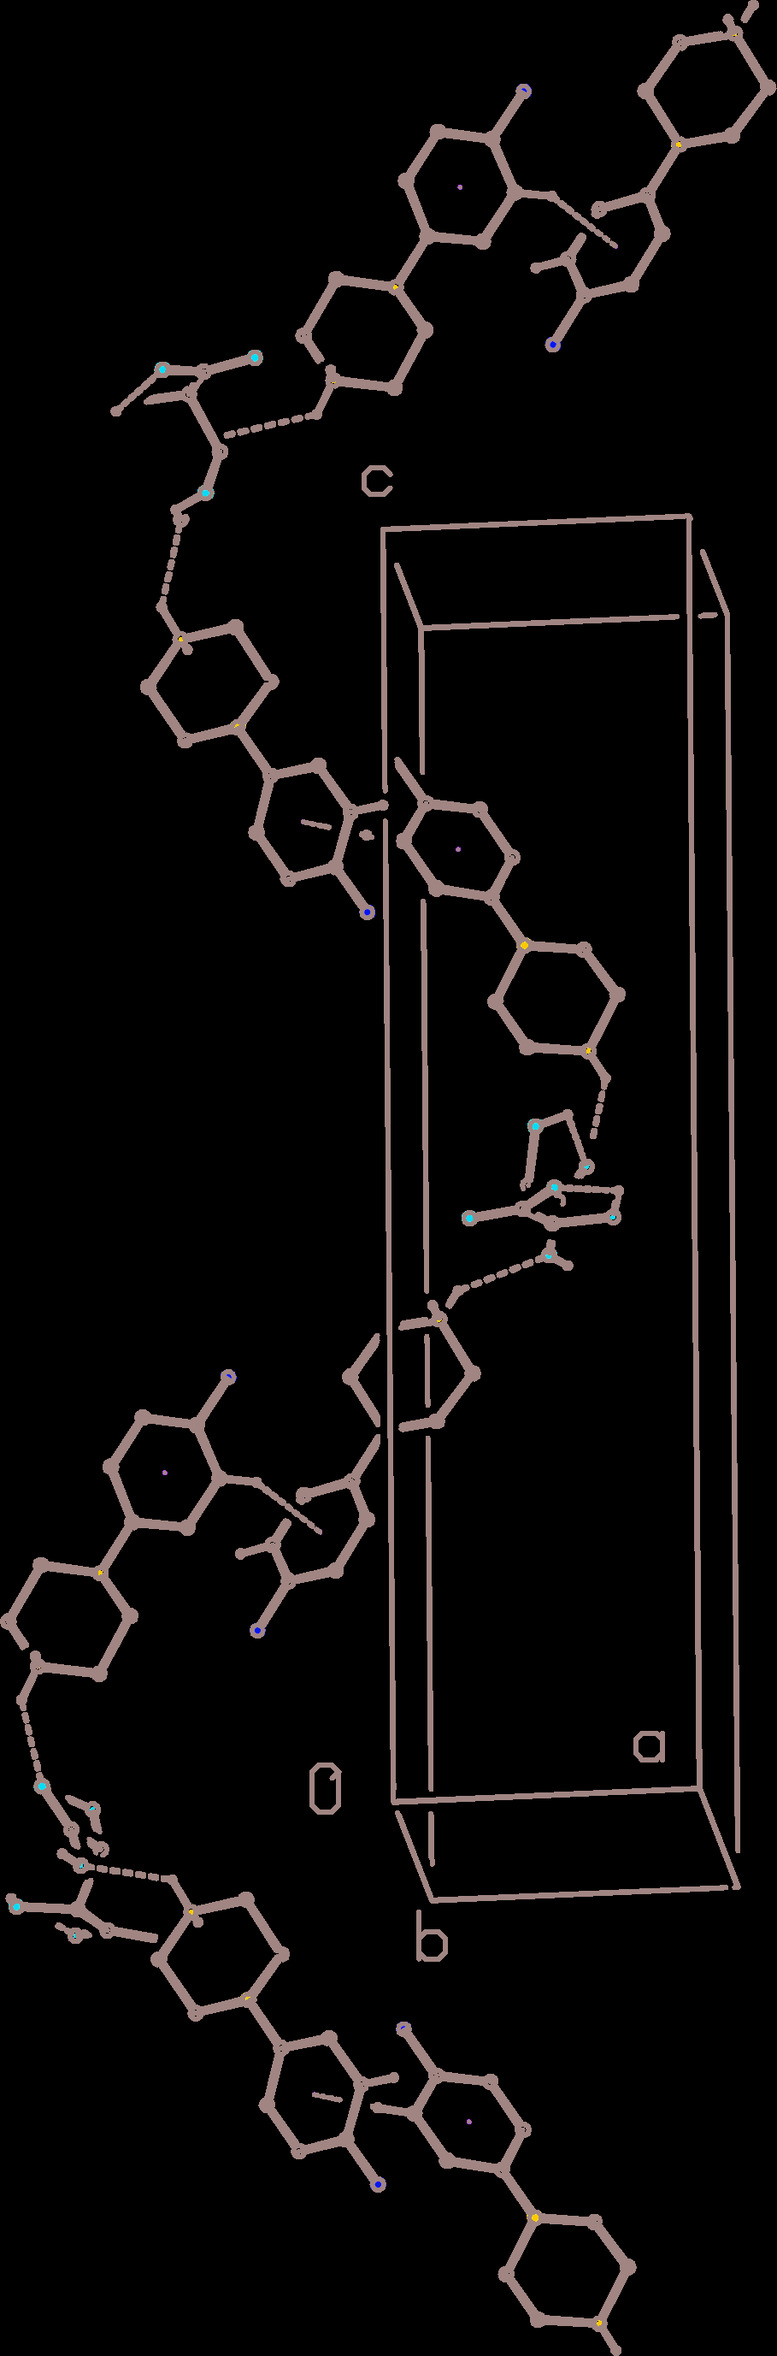
Part of the crystal structure of compound (III) showing the formation of a hydrogen-bonded chain of cations and anions running parallel to the [001] direction. Hydrogen bonds are drawn as dashed lines and, for the sake of clarity, the water mol­ecules and the H atoms not involved in the motif shown have been omitted.